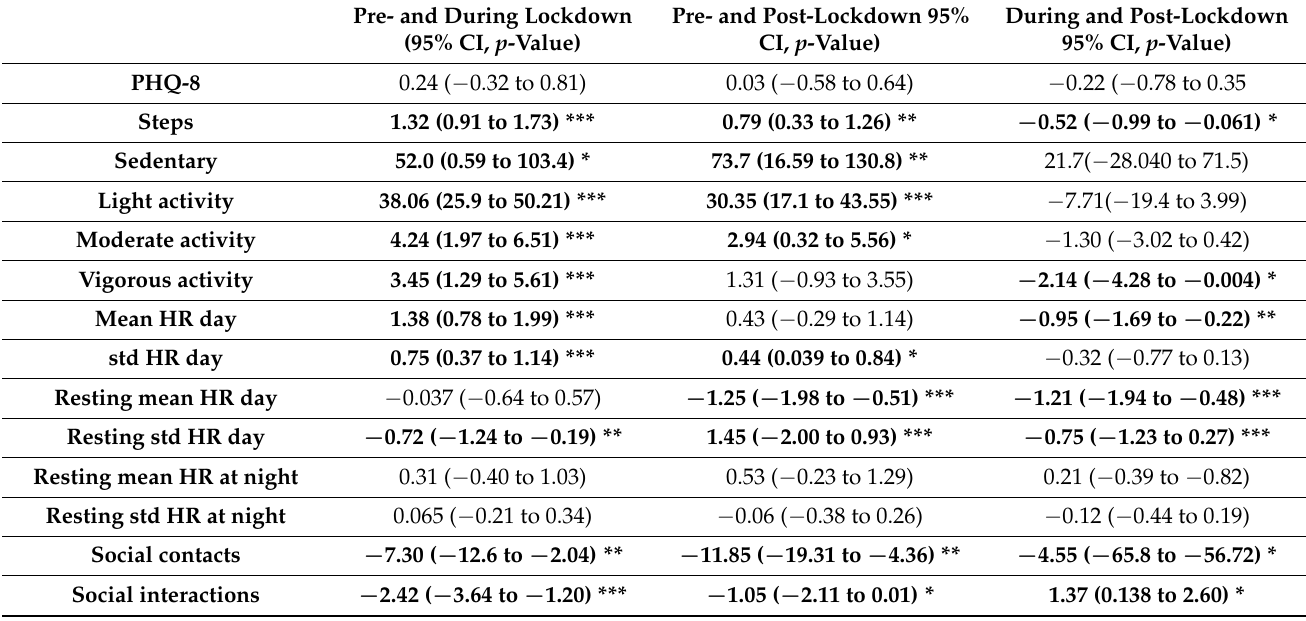
Table 3. Estimated mean differences in each outcome between periods in MDD (Linear mixed- effects